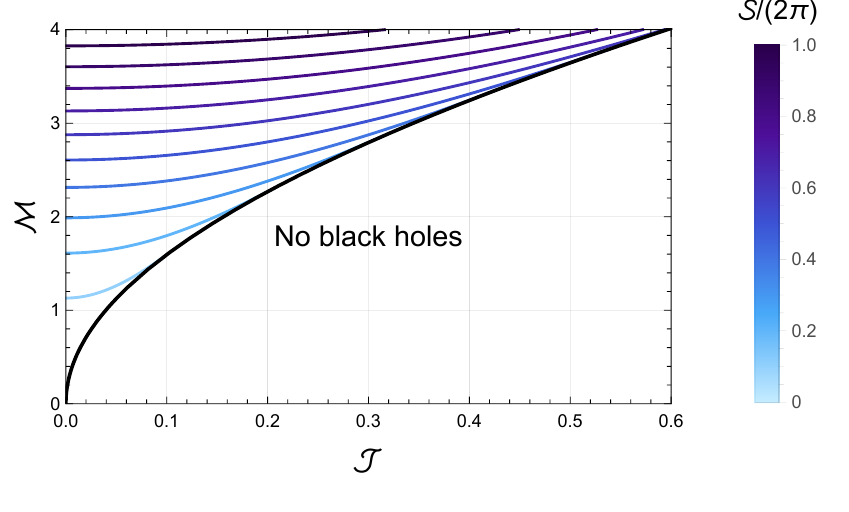
Figure 4 . Contours of the entropy of Kerr-AdS 4